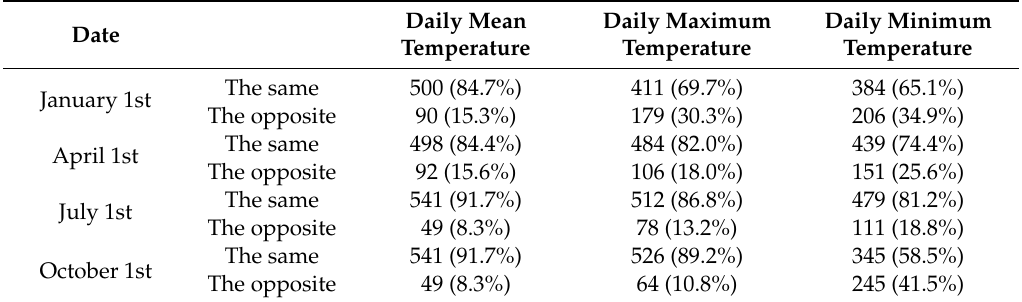
Table 1. The number and percentage (in bracket) of the sites where the observed and gridded daily data are with the same climate trends (OGSP index) and opposite climate trends (OGOP index) in mainland China.